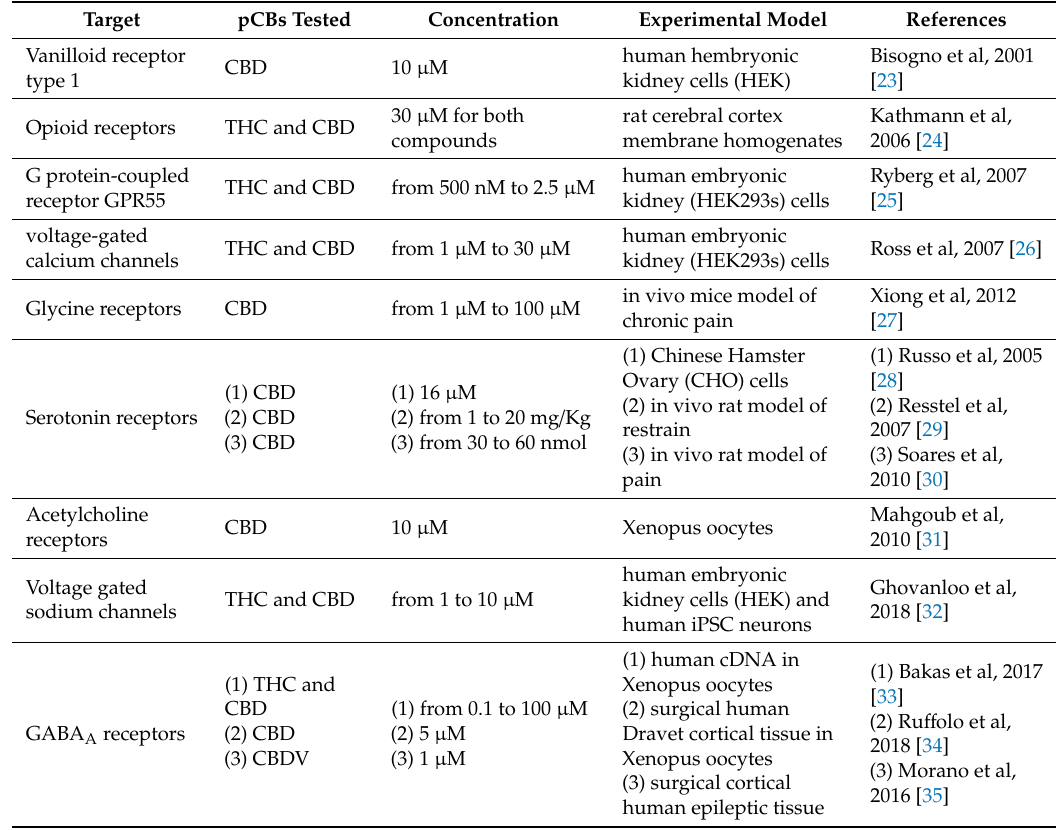
Table 1. Summary of main targets of